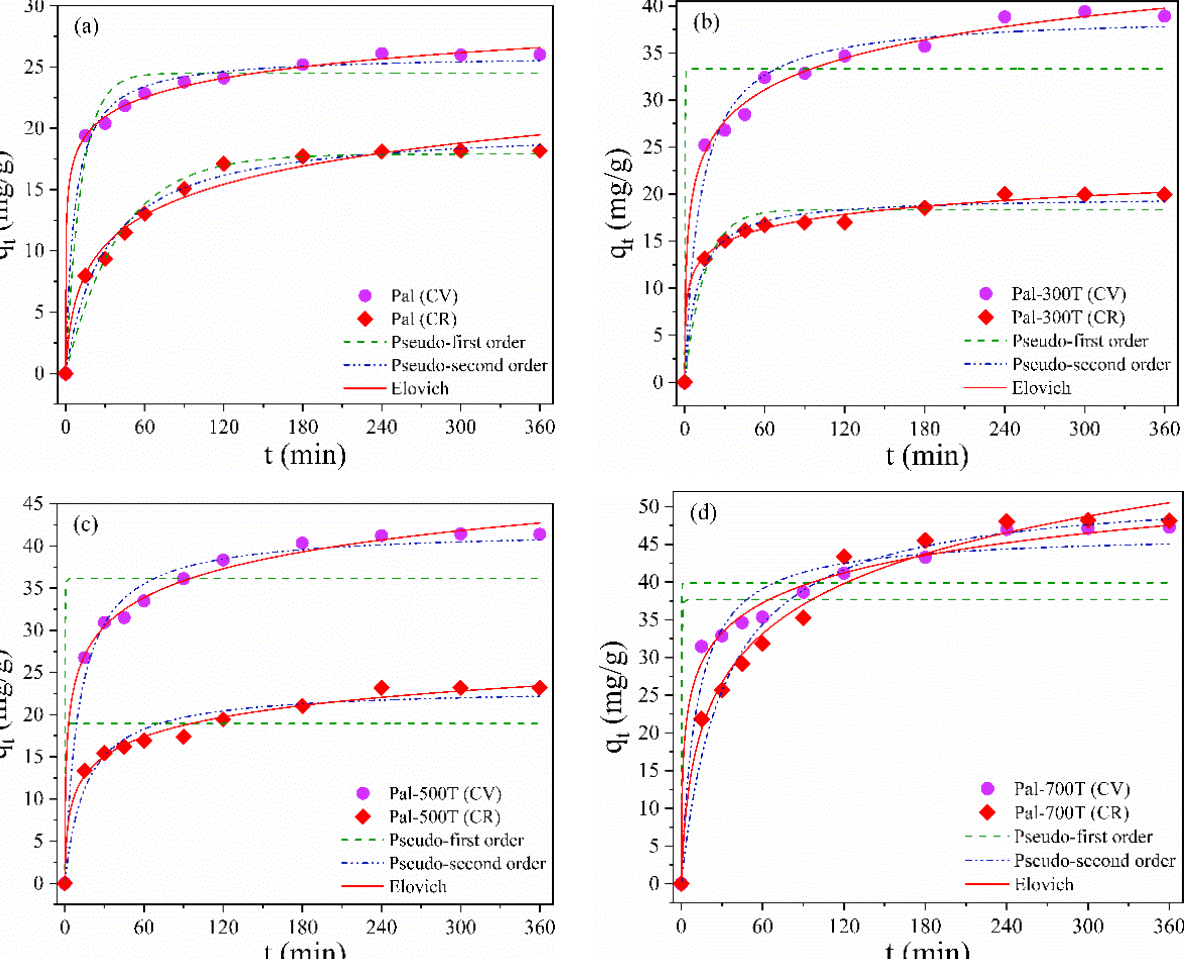
Figure 6. Nonlinear adsorption kinetic models (Pseudo-first order, Pseudo-second order and Elovich) of CV and CR for ( a ) Pal, ( b ) Pal-300T, ( c ) Pal-500T and ( d ) Pal-700T. Table 4. Pseudo-first order, Pseudo-second order and Elovich kinetic parameters for CV and CR adsorption.